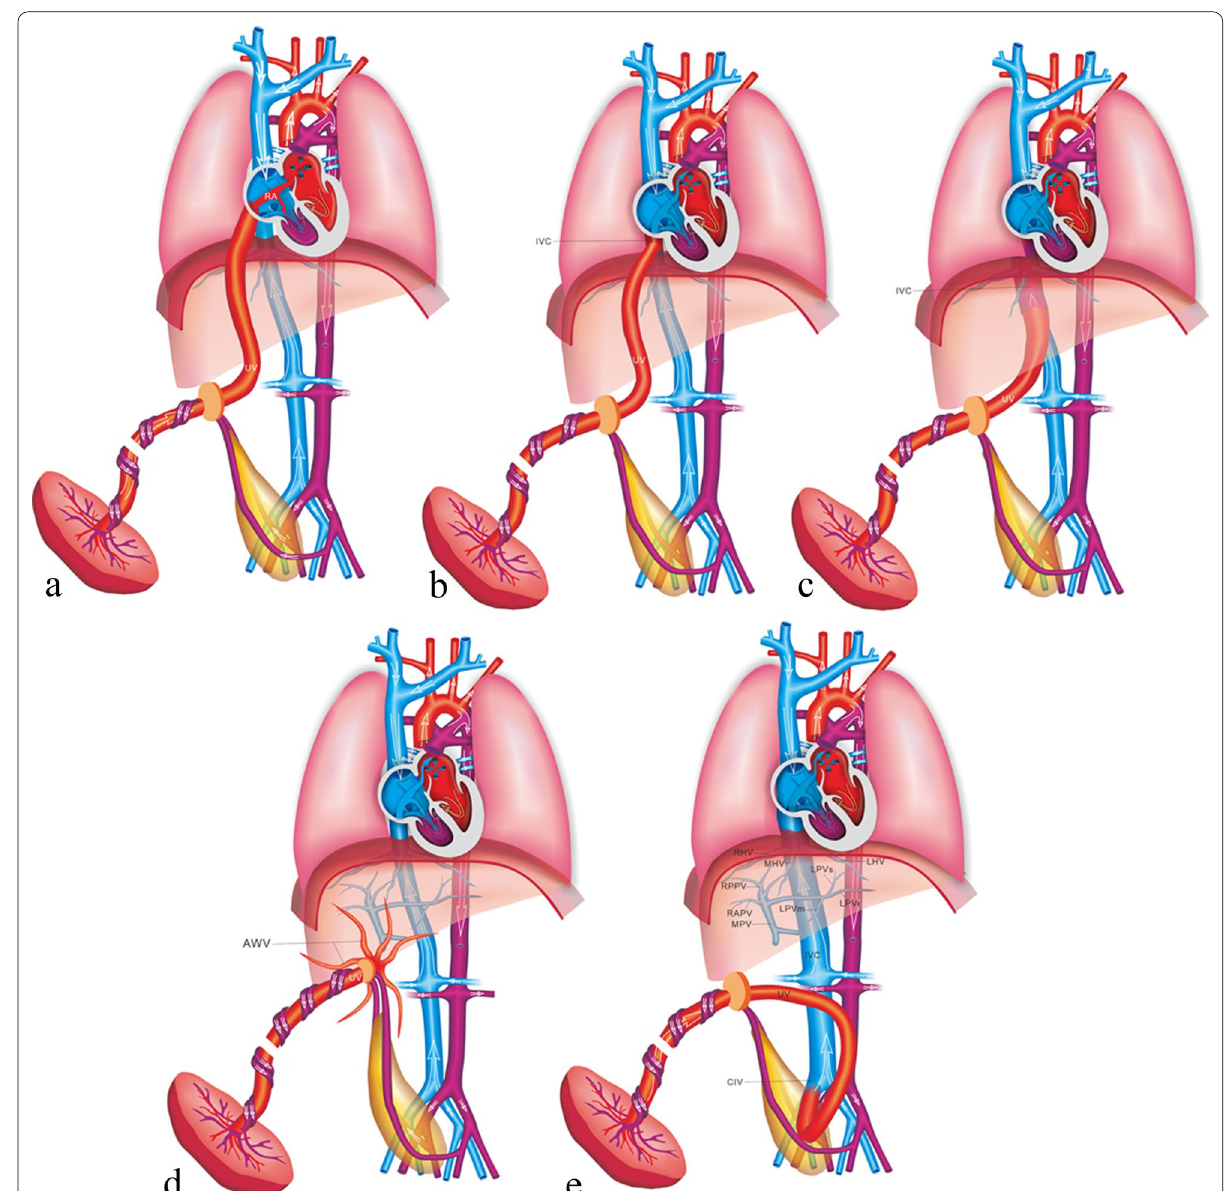
Fig. 15 Schematic drawing of the USS. The UV directly connects to the right atrium ( a ), the intra-thoracic IVC ( b ), the abdominal IVC ( c ), the AWV ( d ), and the CIV ( e